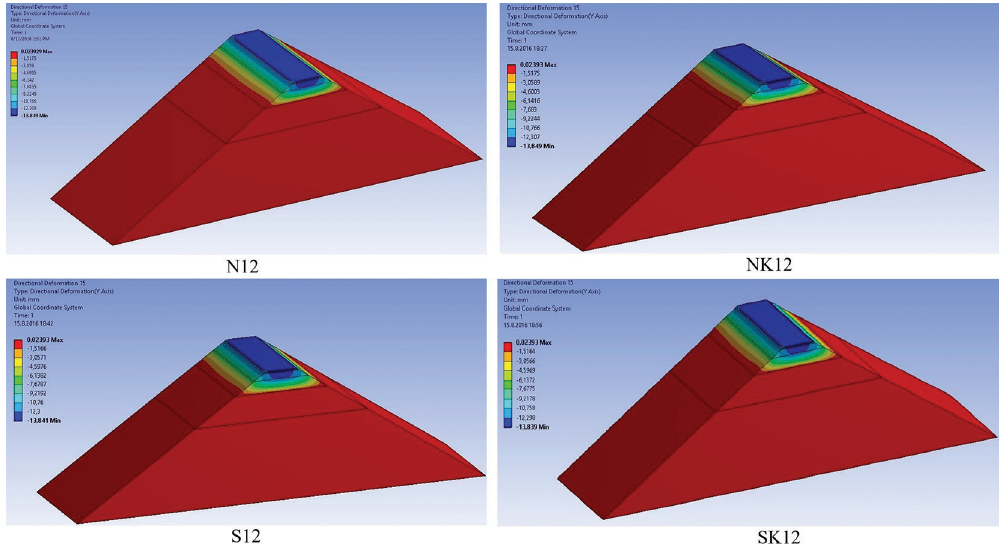
Figure 8. Vertical deformations on FEM models for all the layers